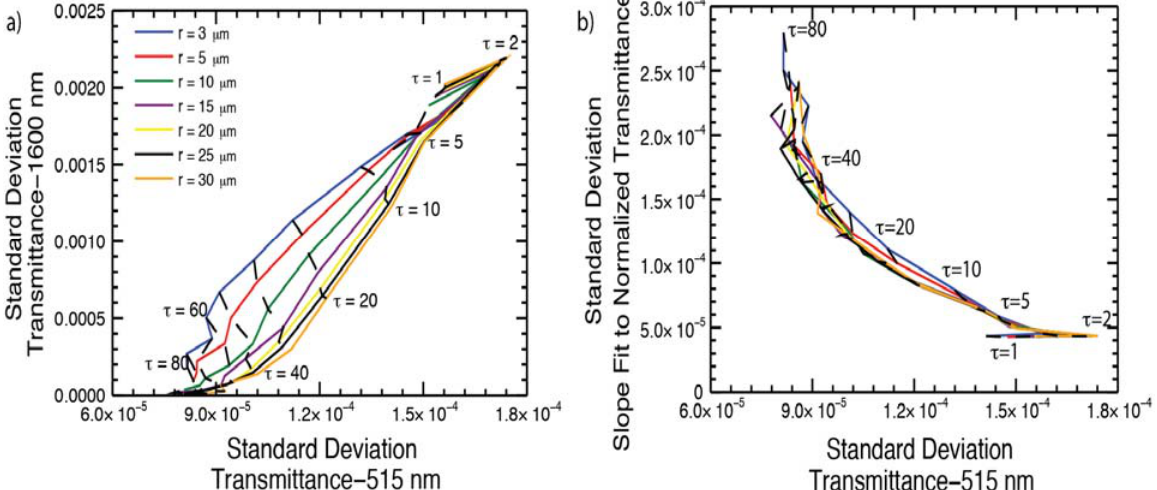
Figure 2. Standard deviation in transmittance as a function of τ and r method and ( b ) spectral slope method due to a +3% systematic measurement error and ±30% change in water vapor. Calculations shown are for μ albedo. Plot details are as described in Figure